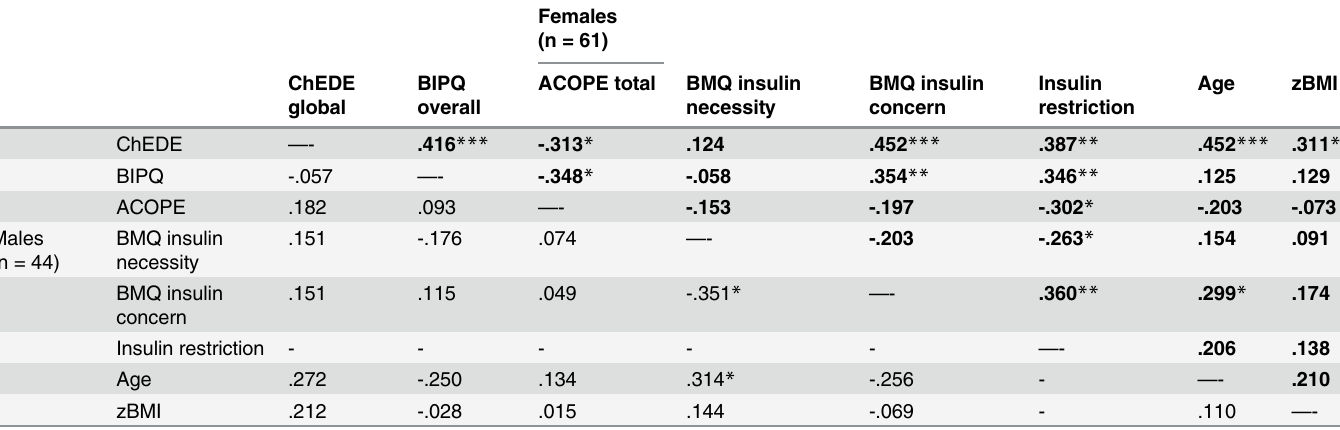
Table 2. Correlations between eating disorder psychopathology and illness perceptions (BIPQ), coping strategies (ACOPE), insulin beliefs (BMQ), insulin restriction due to weight- and shape concerns, age and